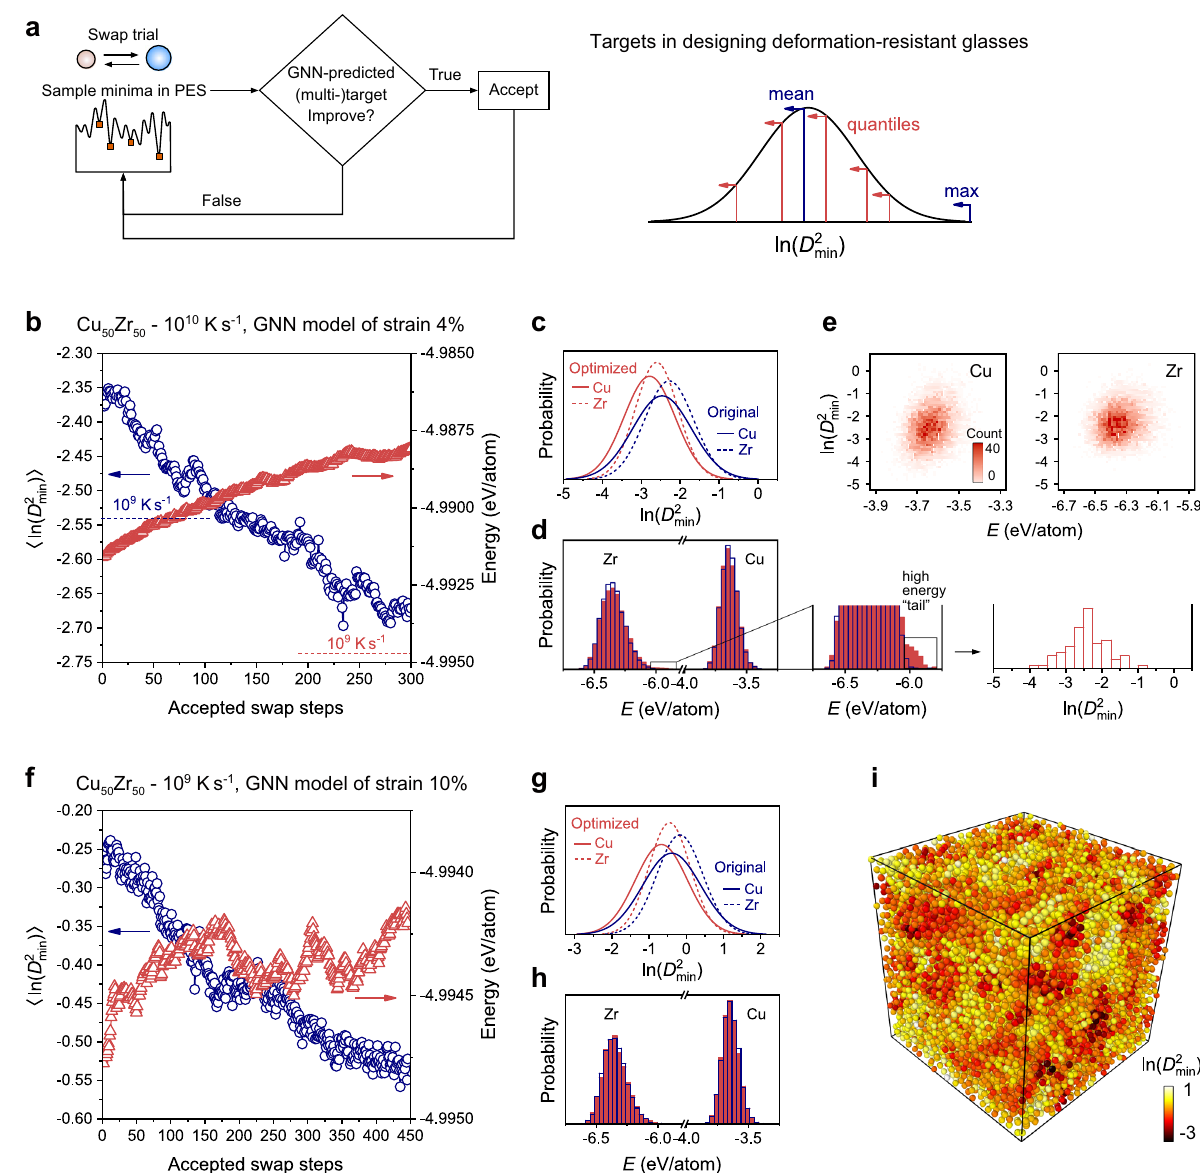
Fig. 3 Inverse design of deformation-resistant glass structure. a Schematic of the iterative design scheme, based on swap MC as a sampler and GNN as a decider. The right panel shows the targets to be optimized (the maximum, mean, and quantiles) in designing the deformation-resistant glasses. b Evolution Þ and energy, when using the GNN model for strain 4% to optimize a Cu − 10 10 K s − 1 con fi guration. c Distribution of of con fi guration-average ln ð D 2 50 Zr 50 min Þ of Cu and Zr atoms before and after optimization. d Distribution of energy before (blue, open histograms) and after (red, fi lled histograms) In ð D 2 min Þ the distribution of these high-energy atoms are presented optimization. A high-energy tail in the energy spectra of Zr atoms is highlighted and the In ð D 2 min Þ . f Evolution of con fi guration-average ln ð D 2 Þ and energy when using the GNN in the right panel. e Weak correlation between local energy and In ð D 2 min min Þ before and after optimization. h The distribution of model for strain 10% to optimize a Cu 50 Zr 50 − 10 9 K s − 1 con fi guration. g The distribution of In ð D 2 min Þ distribution of the optimized con fi guration. A systematic decrease of In ð D 2 Þ can be energy before and after optimization. i The simulated In ð D 2 min min observed with comparison to the original state ( “ Target ” , upper left in Fig.